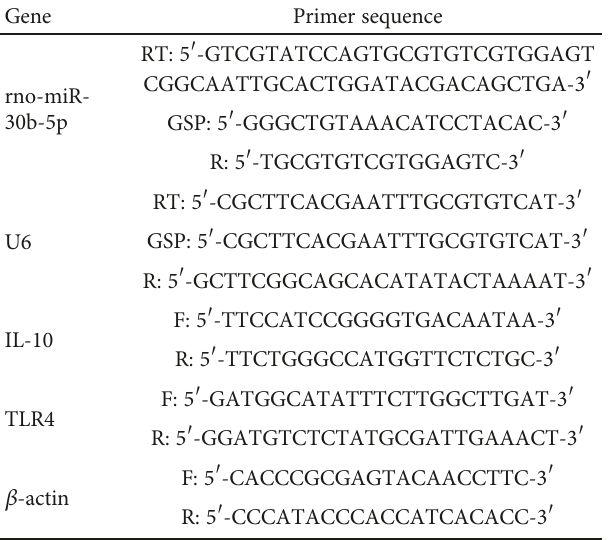
Table 1: Primer sequence of